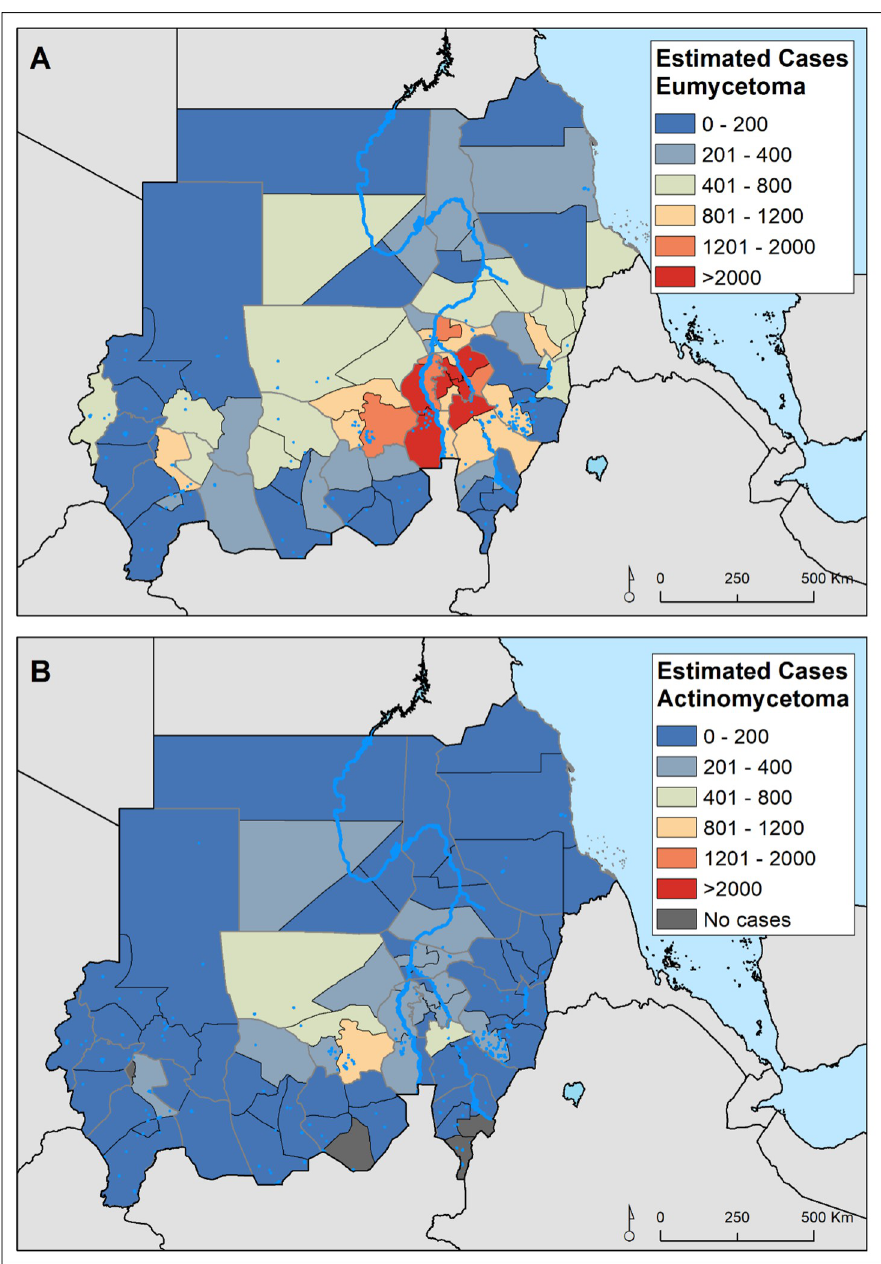
Fig 5. Estimated number of people that have eumycetoma (A) and actinomycetoma (B) between 1991 and 2018 as predicted by the fitted model-based geostatistical models.